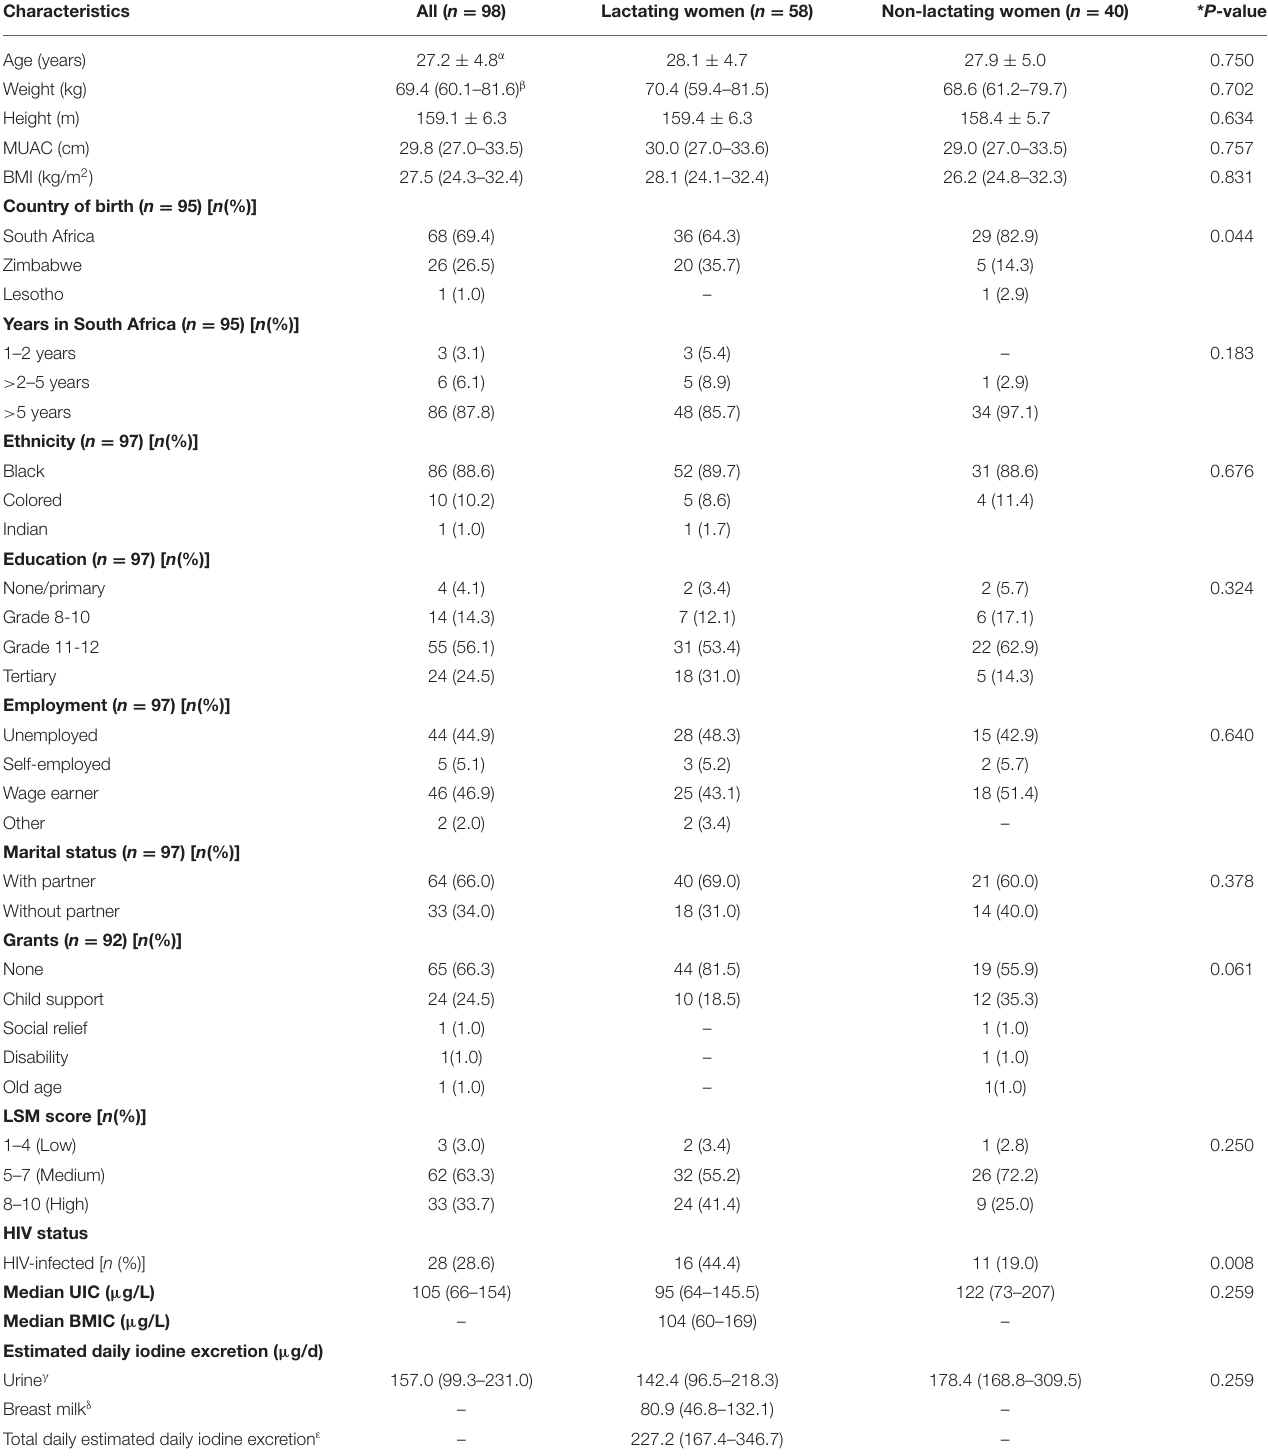
TABLE 3 | Participant